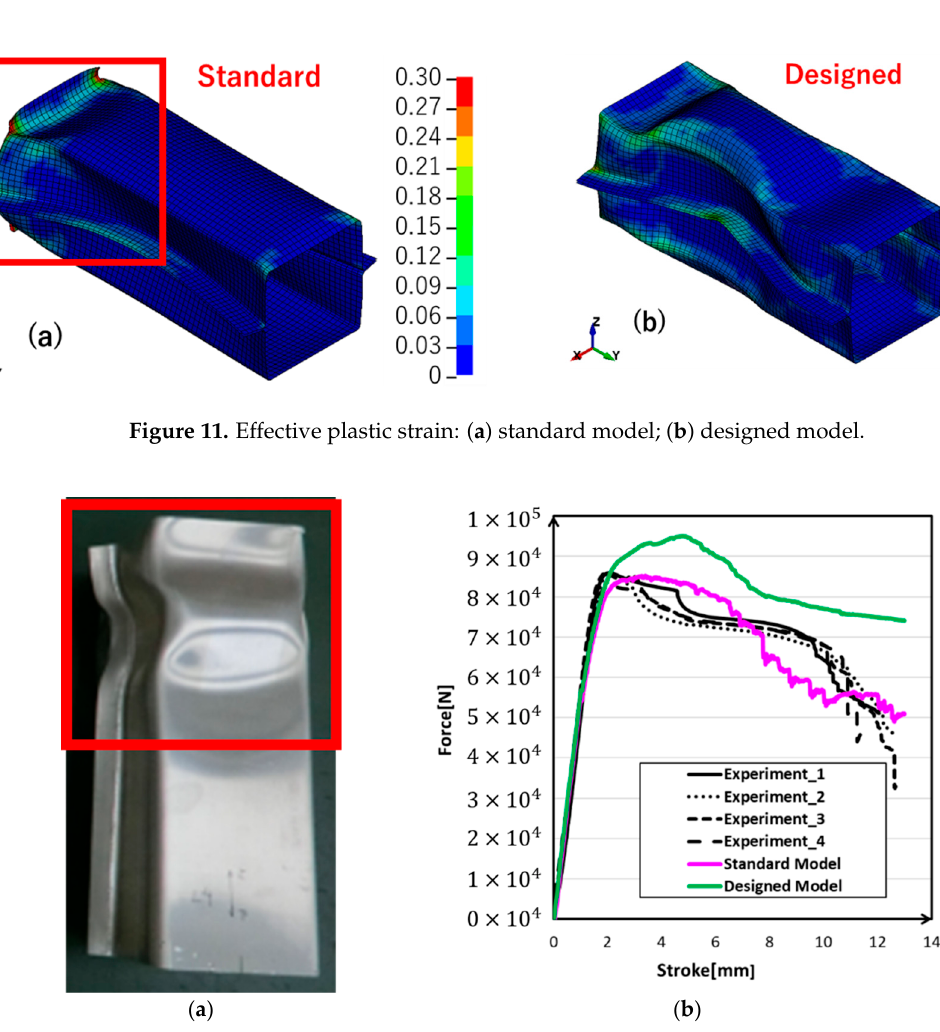
Figure 12. Experiment result: ( a ) deformation mode; ( b ) force-stroke curves.